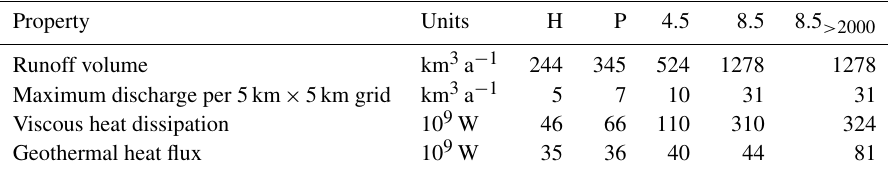
Table 1. Properties of Greenland runoff and viscous heat dissipation. Historical (H) period covers 1960–1999, present spans (P) 2010–2019, and the RCPs 4.5 and 8.5 periods span 2090–2099. Column 8.5 > 2000 shows model results when runoff can access the bed at all elevations. Runoff volume from MAR (Fettweis et al., 2013). Geothermal heat flux from Shapiro and Ritzwoller (2004) calculated only under runoff